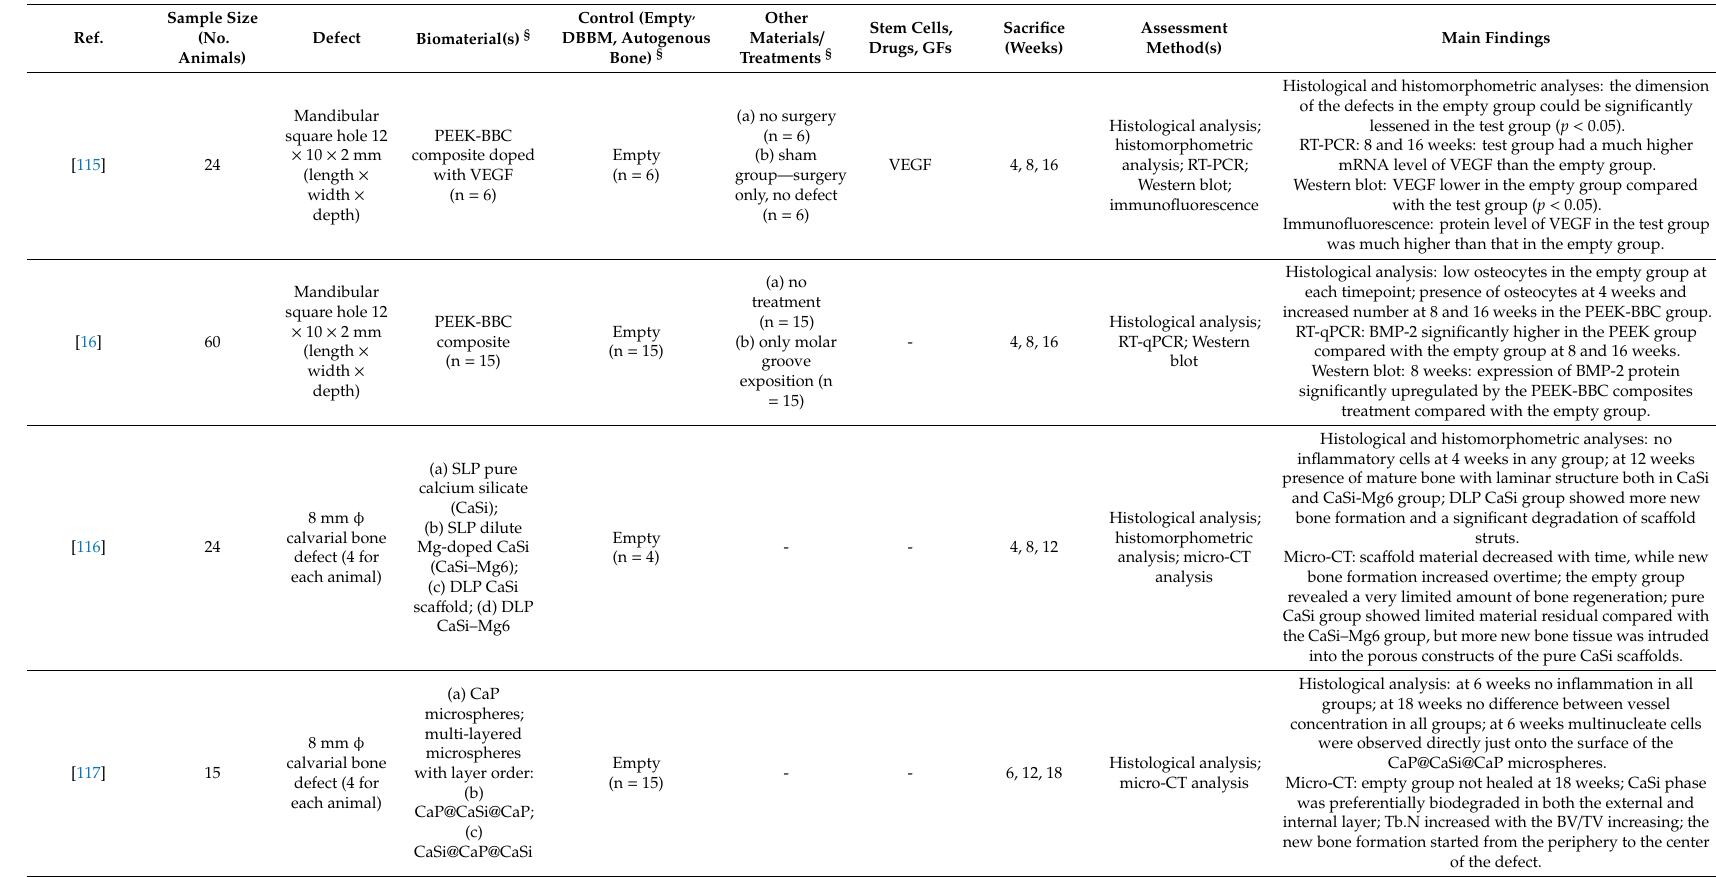
Table 5. Summary of the characteristics and main results of studies in rabbits (n = 7).